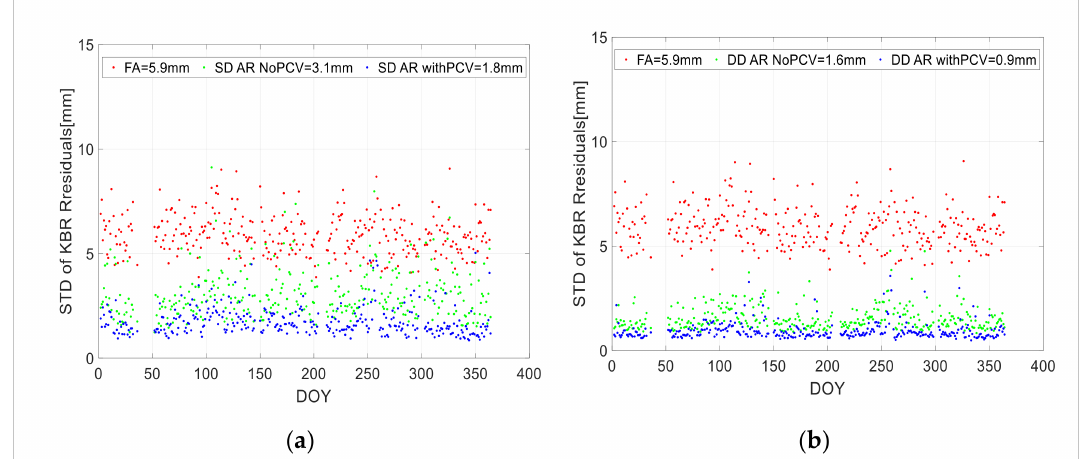
Figure 10. Daily STDs of KBR residuals of ( a ) FA orbit with PCV corrections (red dots), SD AR orbit without PCV corrections (green dots), and SD AR orbit with PCV corrections (blue dots); ( b ) FA orbit with PCV corrections (red dots), DD AR orbit without PCV corrections (green dots), and DD AR orbit with PCV corrections (blue